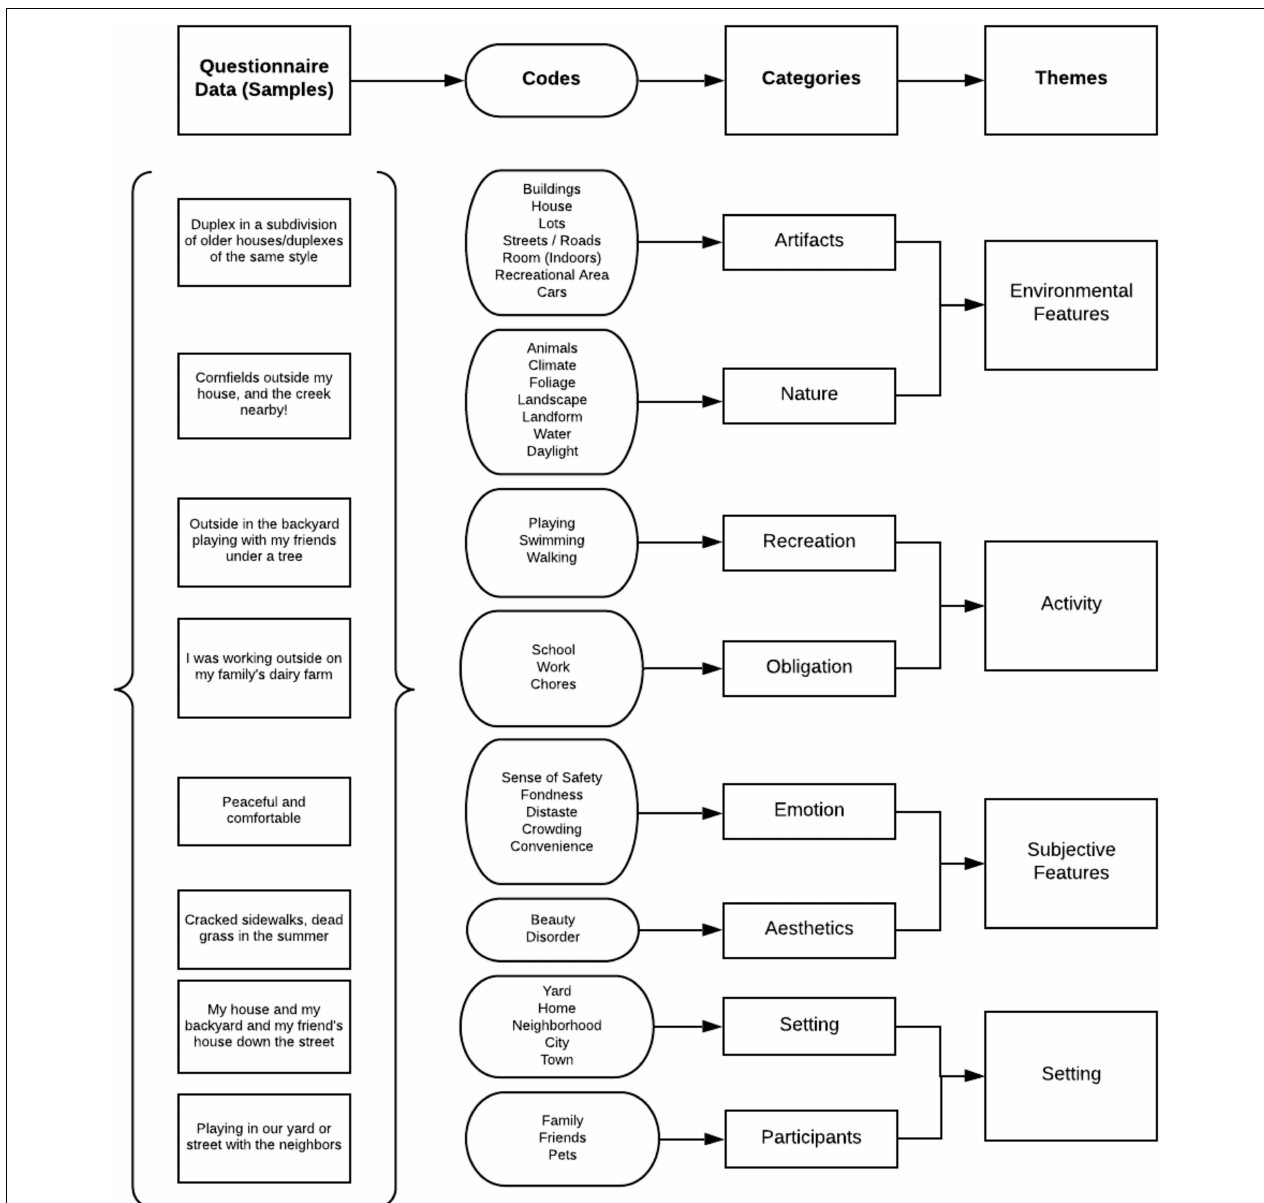
FIGURE 2 | Qualitative elements of the childhood nature experience.